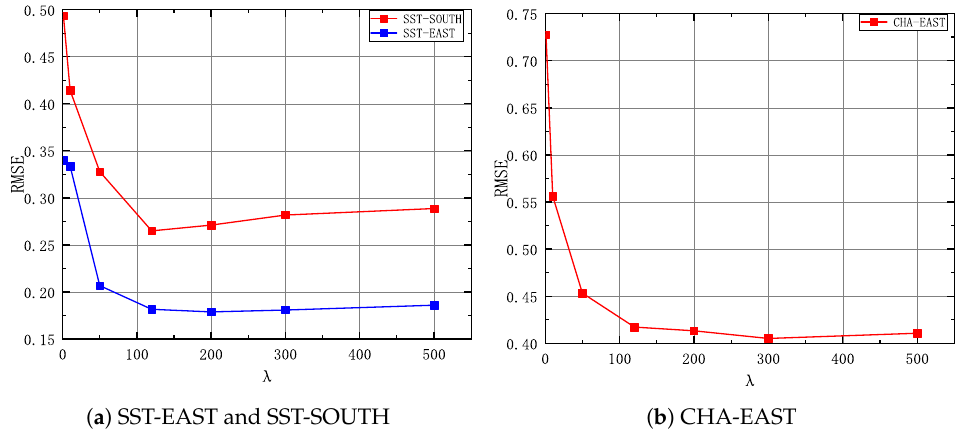
Figure 11. The RMSE of STA-GAN model while varying λ , where the missing rate is